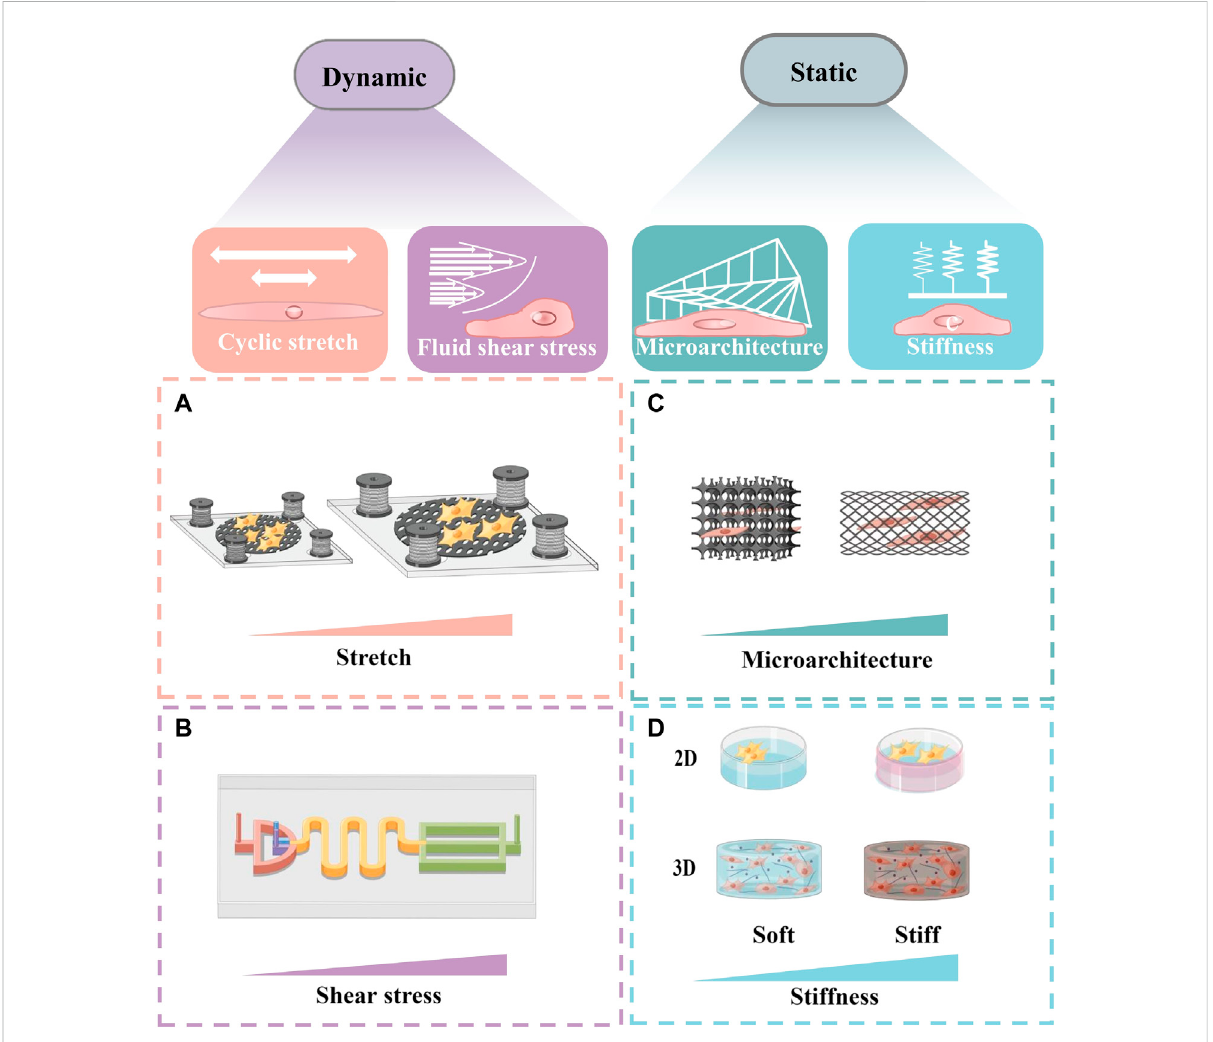
FIGURE 3 Schematic of several in vitro models simulating the change of biomechanical traits. Schematic diagrams were drew online using Figdraw. (A) A schematic diagram of a stretch system to apply long-term cyclic stretch to cells. (B) A schematic diagram of the equipment, which can generate shear force and rotational shear force respectively to simulate the fl uid shear stress in vitro . (C) A scalable microarchitecture-cultivation platform for engineering cardiac tissues. (D) A schematic diagram of cells cultured in different matrix stiffness in 2D and